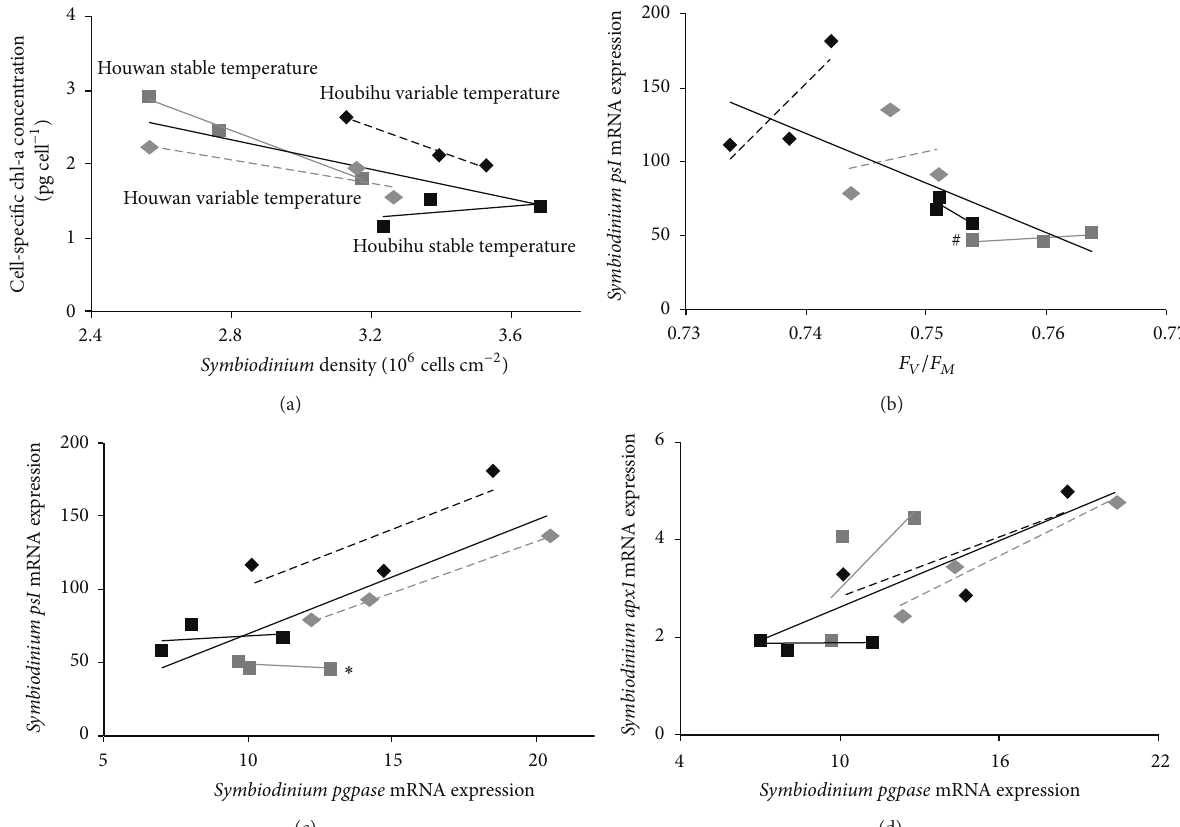
Figure 4: Correlations. Multivariate correlation analyses were run on both the physiological and molecular data, and the four strongest asso- ciations were selected for plotting. There were statistically significant, negative correlations between cell-specific chlorophyll a (chl- a ) concen- tration and Symbiodinium density (a), as well as between Symbiodinium photosystem I ( psI , subunit III) mRNA expression and the maximum dark-adapted quantum yield of photosystem II ( 𝐹 𝑉 /𝐹 𝑀 ; (b)). There were statistically significant, globally positive correlations between Symbiodinium psI and phosphoglycolate phosphatase ( pgpase ) gene expression (c), as well as between Symbiodinium ascorbate peroxidase ( apx1 ) and pgpase gene expression (d). In all cases, correlations were assessed across the dataset as a whole, and the global correlations are representedbysolidblacklinesthatspantheentirepanel.Individualcorrelationswerethenassessedwithineachsiteoforiginandtemperature treatment, and the corals from Houbihu exposed to a variable and stable temperature regime are denoted by black diamonds and squares, respectively. The Houbihu variable and stable temperature regime trend lines are dotted and solid black, respectively. Similarly, the corals from Houwan exposed to a variable and stable temperature regime are denoted by grey diamonds and squares, respectively, and are associated with grey dotted and grey solid trend lines, respectively. When a statistically significant difference between slopes of two temperature treatments within a site was documented with ANCOVA ( 𝑃 < 0.05 ), an asterisk ( ∗ ) was placed next to one of the two trend lines. When a statistically significant difference between slopes of two sites within a temperature treatment was documented with ANCOVA ( 𝑃 < 0.05 ), a “#” was placed next to one of the two trend